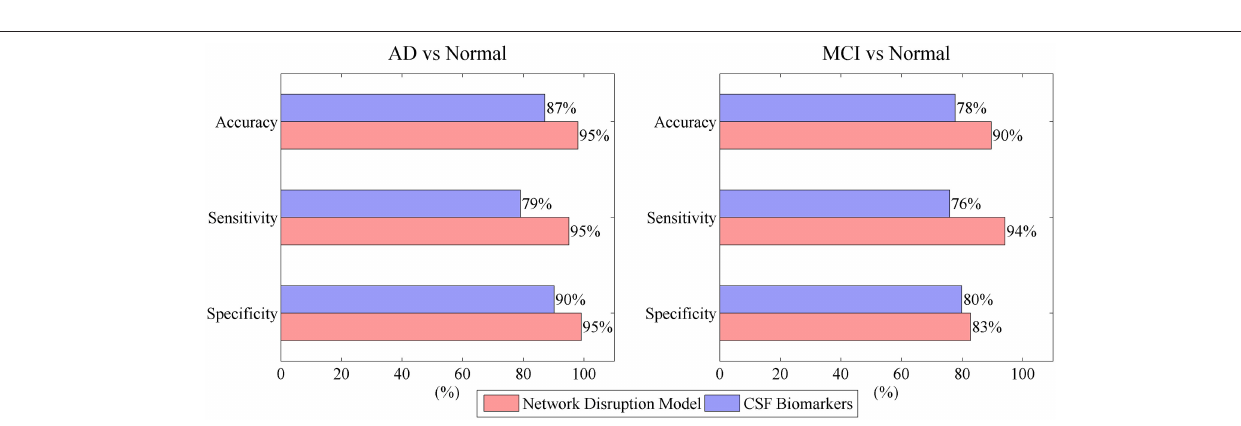
FIGURE 5 | Model performance in classification of AD vs. normal and MCI vs.